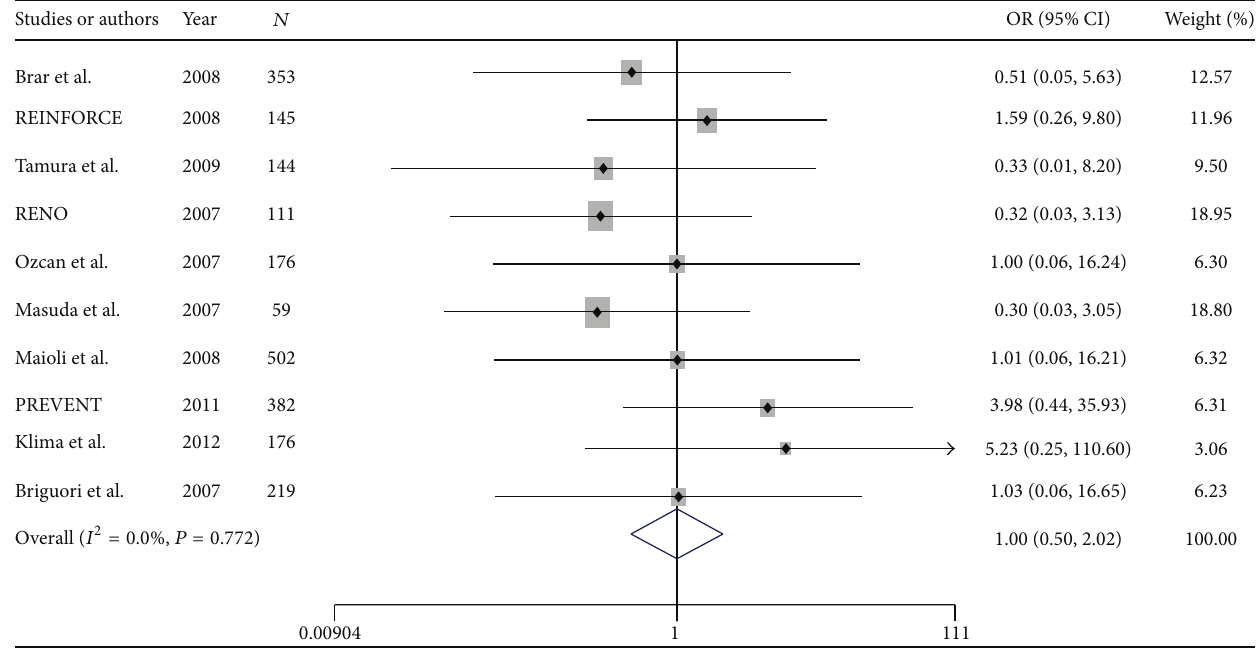
Ratcliffe et al.